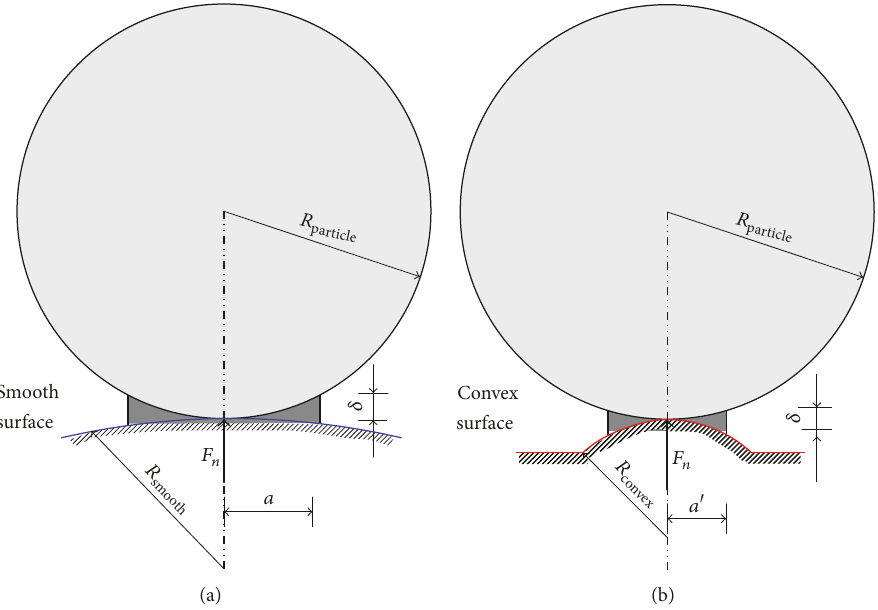
Figure 7: Contact model of different surface: (a) smooth surface contacts with particle and (b) convex surface contacts with particle.